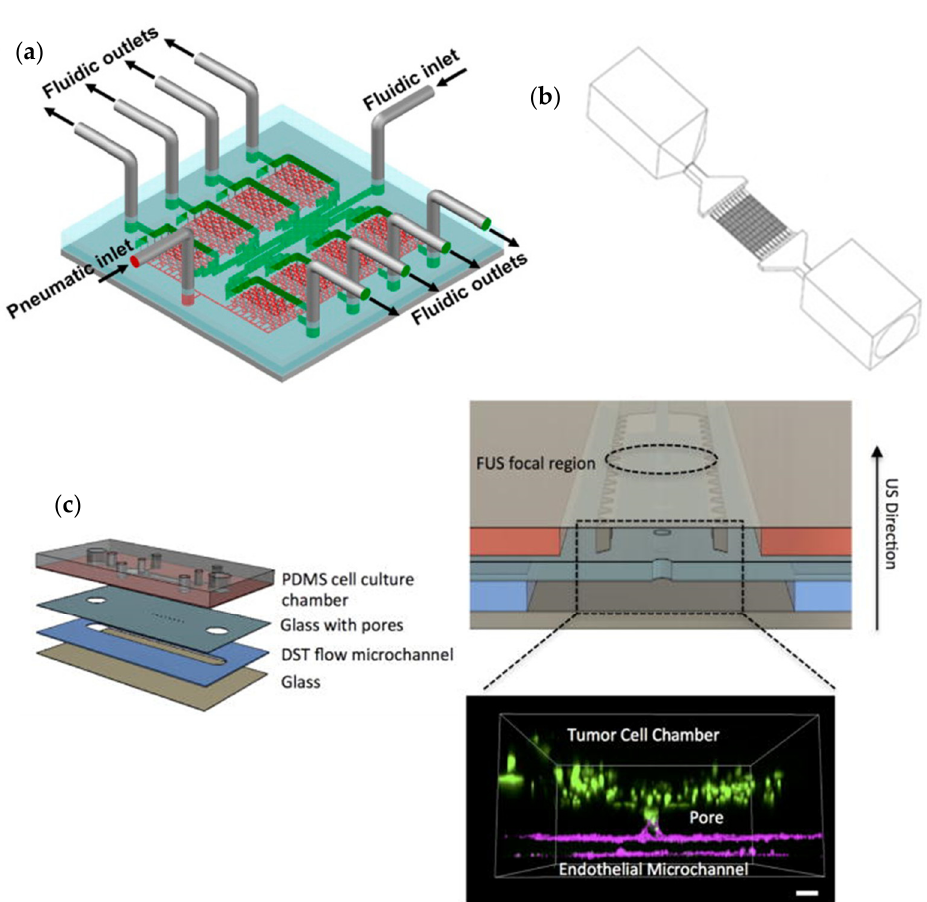
Figure 3. ( a ) Schematic representation of a microfluidic device for repeatable 3D culture of glioblas- toma cells used by Liu et al. [26]. Reprinted with permission from [26]; ( b ) Perspective view of the entire microfluidic device developed by Tricinci et al. [28] for BBB mimicking and glioblastoma spheroids culture. Reprinted with permission from [28]; ( c ) Different layers of the microfluidic device for glioblastoma 3D cell culture proposed by Zervantonakis and Arvanitis [29]. Reprinted with permission from [29].